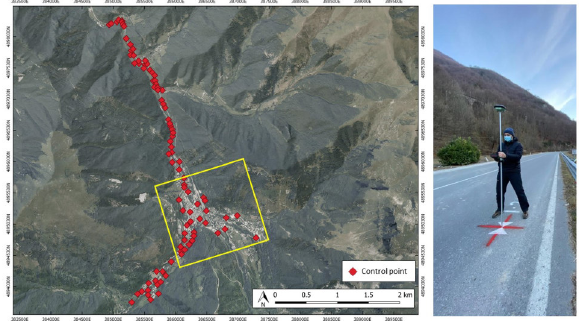
Figure 3. The position of the surveyed points materialized in all the area of interest (a portion of the State Highway number 20 and the urban area of Limone